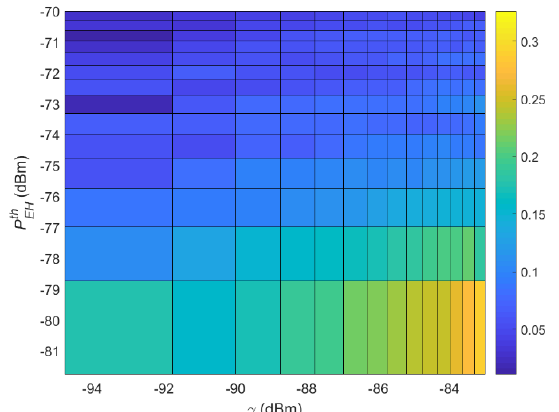
Figure 15. The D2D transmission probability ( 𝑝 𝑡D2D ) vs. the predetermined EH threshold (i.e., 𝑃 𝐸𝐻𝑡ℎ ) and the predefined sensing threshold (i.e., 𝛾 ) of the cognitive D2D transmitters.